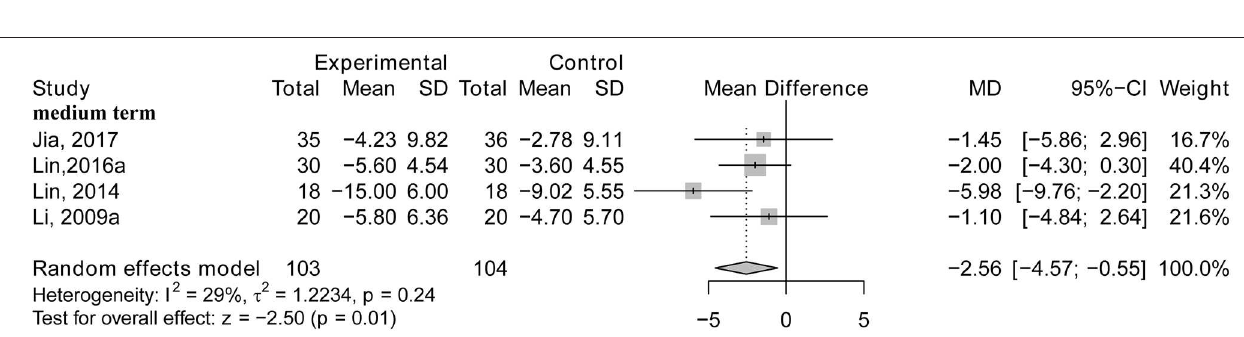
FIGURE 6 | The forest plot of MMSE of acupuncture plus drug therapy vs. drug therapy alone. Lin (2016b), acupuncture plus Donepezil vs. Donepezil; Zhu (2010a), acupuncture plus Yizhijiannao vs. Yizhijiannao; Jiang (2018a), acupuncture plus Jiannaosan vs. Jiannaosan; Li (2009b), acupuncture plus Yizhijiannao vs. Yizhijiannao.